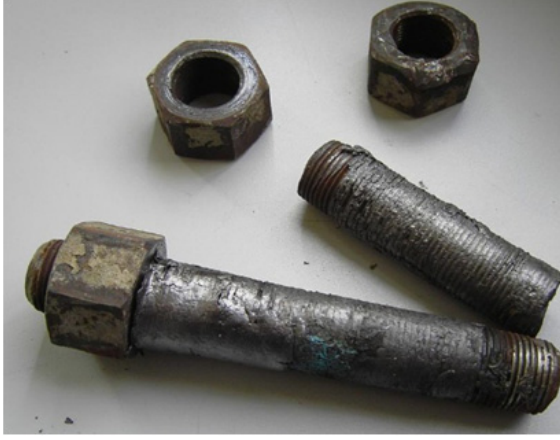
Figure 2: Clear-cut breakages of tie rods.